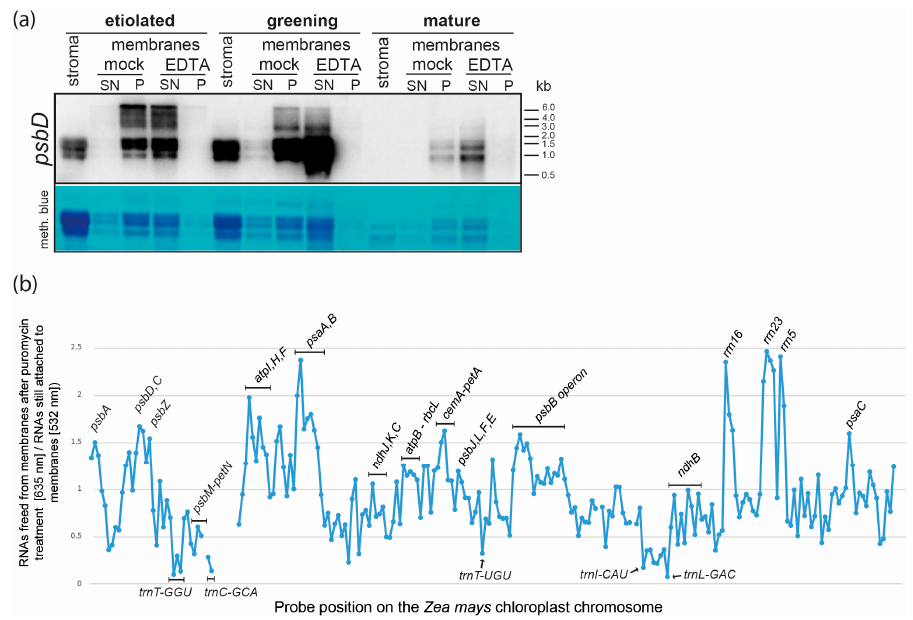
Figure 3. RNAs are associated to chloroplast membranes via translating ribosomes. ( a ) Disruption of ribosomes by ethylenediaminetetraacetic acid (EDTA) releases psbD mRNAs into the soluble fraction. Membrane fractions from the same number of plastids from three different tissue types were either treated with EDTA in order to separate the large and small subunit of the ribosome or were treated with buffer (mock). Membranes were spun down after treatment (P) and the supernatant was collected as well (S). RNA was extracted from all fractions and fractionated on 1.2% agarose gel and analyzed by hybridization to a radiolabeled psbD probe (see Table S4 for primer sequences). As a quality control, the rRNAs were stained with methylene blue; ( b ) Release of mRNAs from chloroplast membranes after puromycin treatment. Membranes were isolated from mature chloroplasts that were purified from four-week-old plants grown under long-day conditions. Membranes were treated with puromycin to release nascent chains and ribosomes from the mRNAs and thus secondarily free mRNAs from the membrane. The membrane was washed multiple times. RNA from the supernatant after puromycin treatment and from the washed membranes was analyzed by a whole genome tiling array of the maize chloroplast genome. The ratio of freed RNA over membrane-bound RNA was calculated for each probe and plotted against genome position. Selected probes are labelled by the gene-names they represent. The isoaceptor tRNAs are named by their respective codon (GGU, GCA, UGU, CAU and GAC,